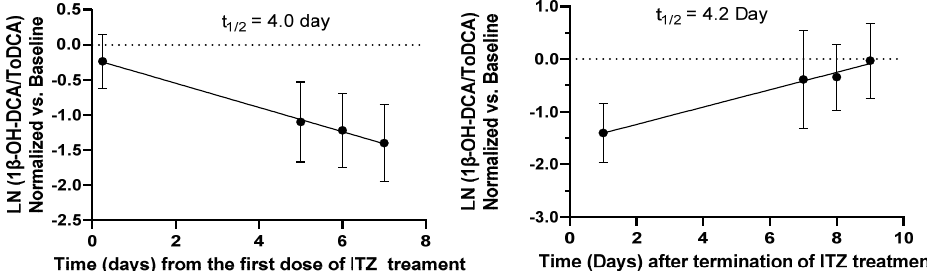
Figure 3. Elimination and recovery curves for urinary 1 β -OH-DCA/ToDCA UMR in ten healthy volunteers treated with ITZ (100 mg od) for 6 days.